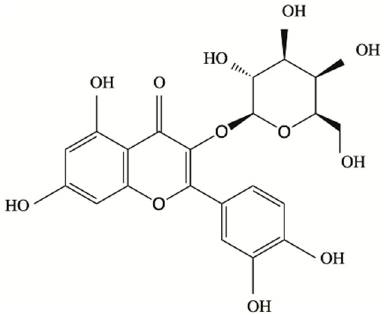
Figure 7. Chemical structure of hyperoside.